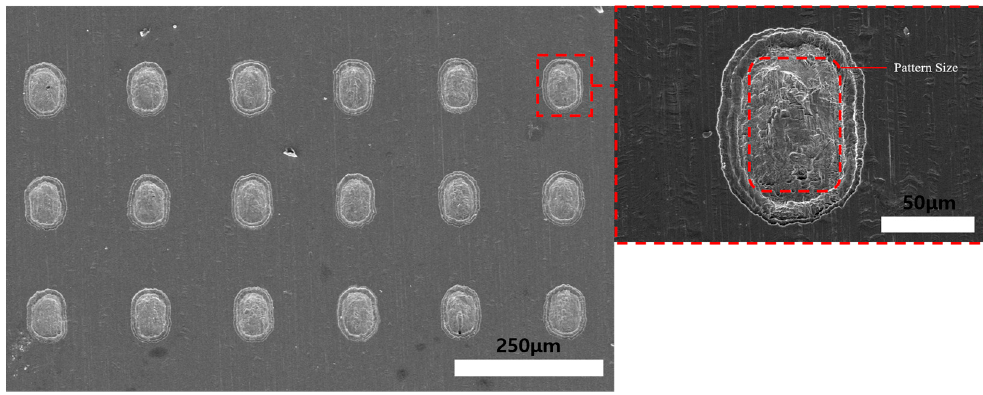
Figure 12. Wet etching and electrochemical fusion machining (photoresist coating face etching).